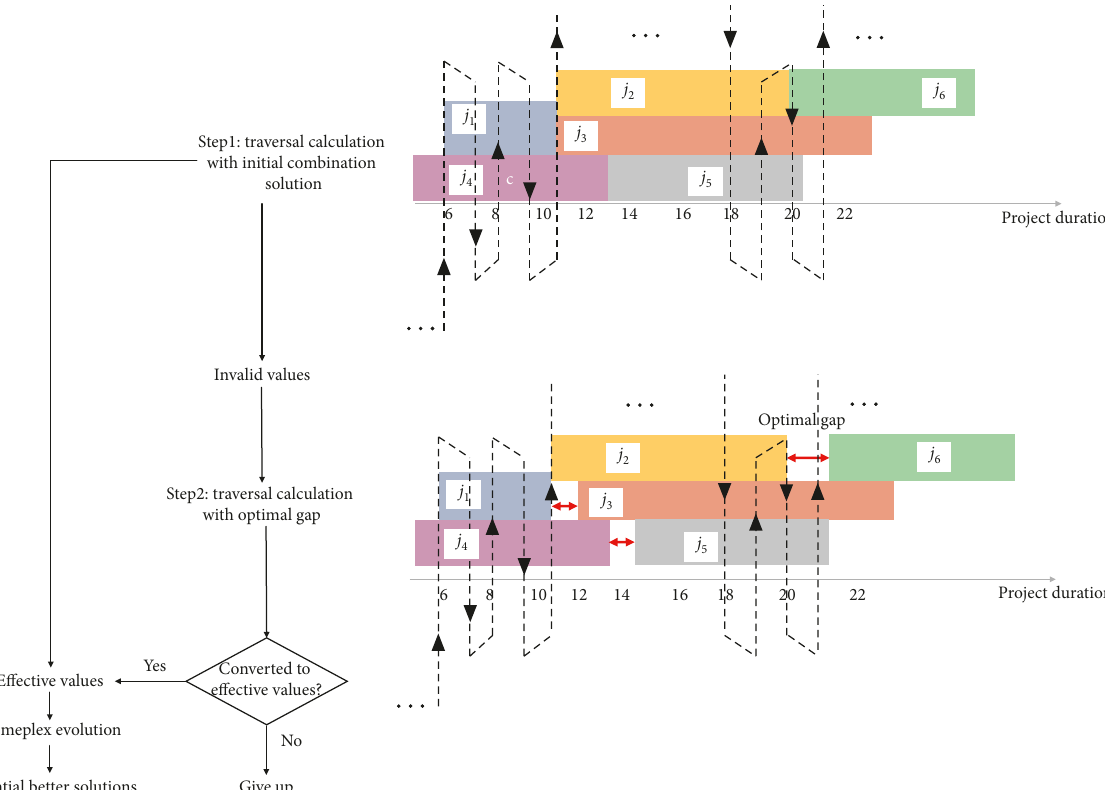
Figure 7: Process of seeking effective solutions in